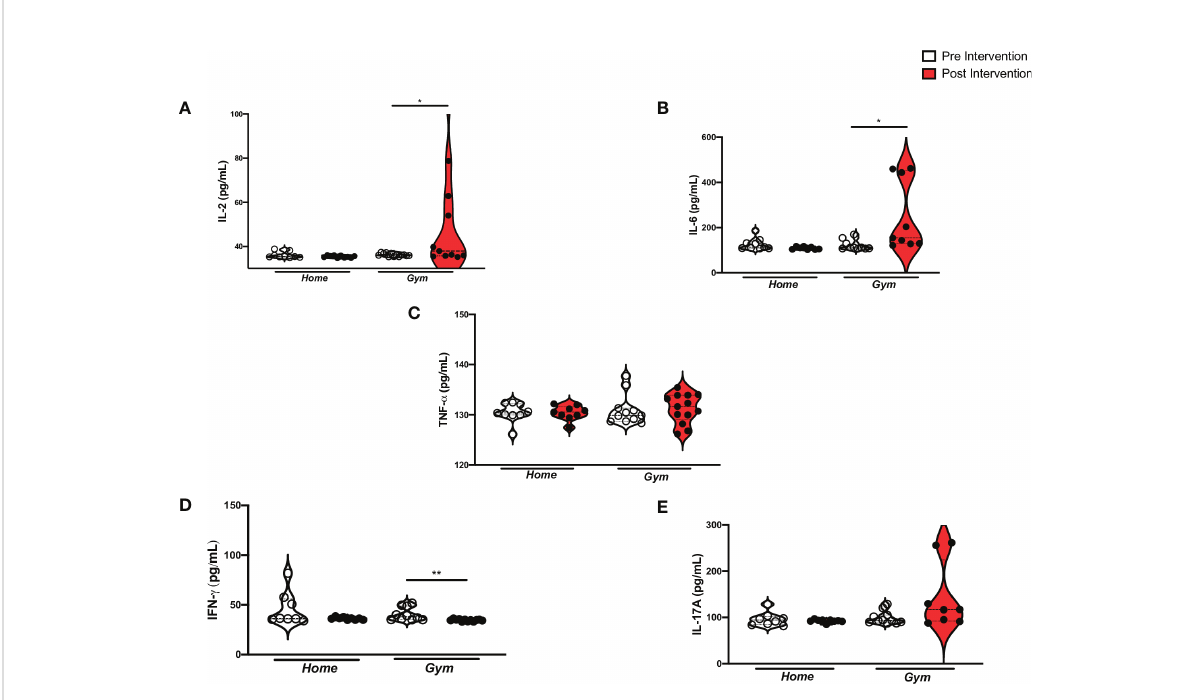
FIGURE 3 Pro-in fl ammatory cytokine levels in Supervised and home-based unsupervised exercise on recovered COVID-19 patients. ANOVA between Supervised and home-based unsupervised exercise on the pro-in fl ammatory cytokines from baseline to 12 weeks of intervention (Pre- and Post-intervention). Home, the home-based unsupervised exercise group; Gym, supervised exercise group; Serum levels; (A) IL-2: Interleukin-2 (home (pre), n= 9, home (post), n= 10; gym (pre), n= 13, gym (post), n= 12; p = 0.02); (B) IL-6: Interleukin-6 (home (pre), n= 9, home (post), n=8; gym (pre), n=10, gym (post), n=10; p = 0.03); (C) TNF- a : Tumor necrosis factor-alpha (home (pre), n= 9, home (post), n= 9; gym (pre), n= 12, gym (post), n= 14; p = n.s); (D) IFN- g : Interferon-gamma (home (pre), n= 8, home (post), n= 9; gym (pre), n=11, gym (post), n=12; p = 0.004); (E) IL-17A, Interleukin-17A (home (pre), n= 8, home (post), n= 9; gym (pre), n= 12, gym (post), n= 8; p = n.s.); pg/mL, picogram per milliliter; *p<0.05 and **p ≤